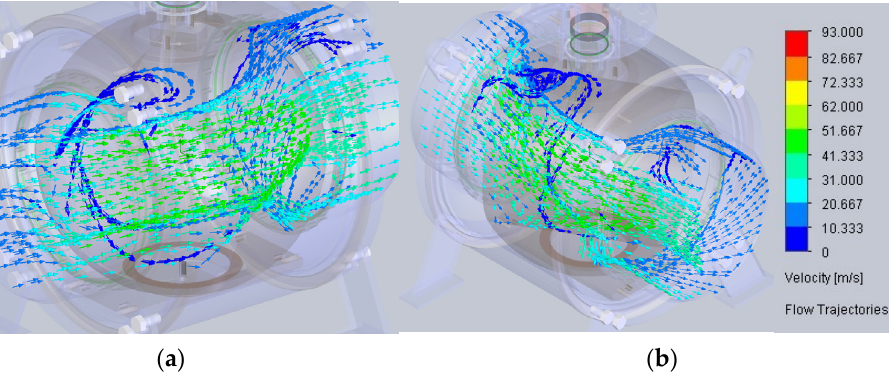
Figure 5. Velocity line trajectories for a 30° closure angle: ( a ) upstream view; ( b ) downstream view.